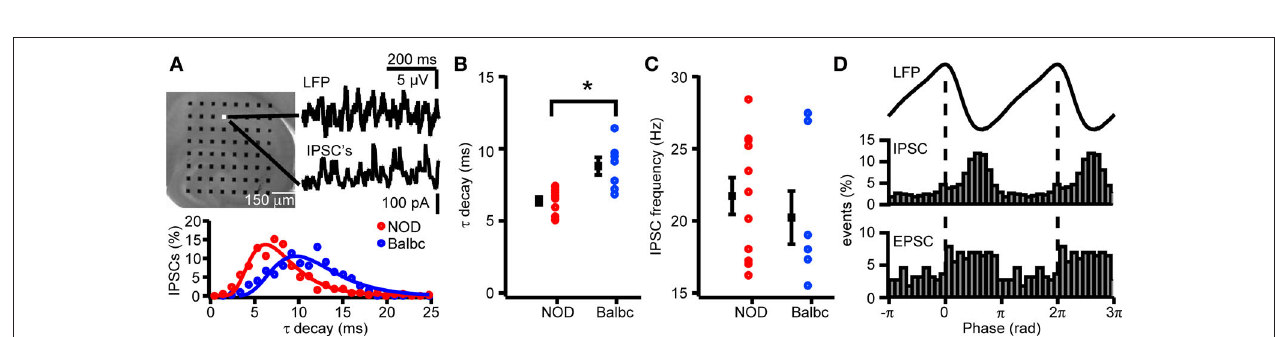
traces of EPSCs in NOD and Balbc mice. (C) EPSC frequency in NOD ( n = 7) and Balbc ( n = 6) mice. (D) Average EPSC amplitude is higher in Balbc mice compared to NOD mice ( p < 0.05). (e) IPSC – field potential phase-locking r values for NOD and Balbc mice. (F) Average phase of IPSCs. Average values + SEM are shown in